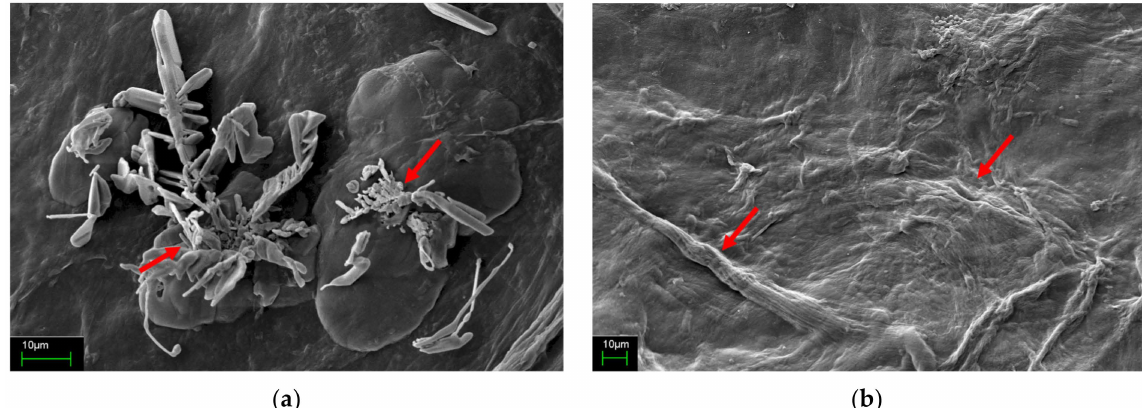
Figure 7. The scanning electron microscopes of wild Malaysian L. rhinocerus strain ABI (1000 × obj) grown in batch fermentation at 30 ◦ C, pH 4, 50 g/L glucose, and 128.24 rpm. ( a ) Dried MB and ( b ) dried EPS. The bars indicate 10 µ